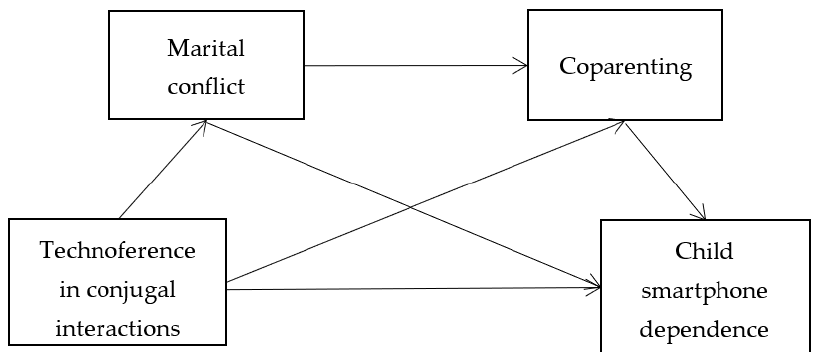
Figure 1. The hypothesized model.